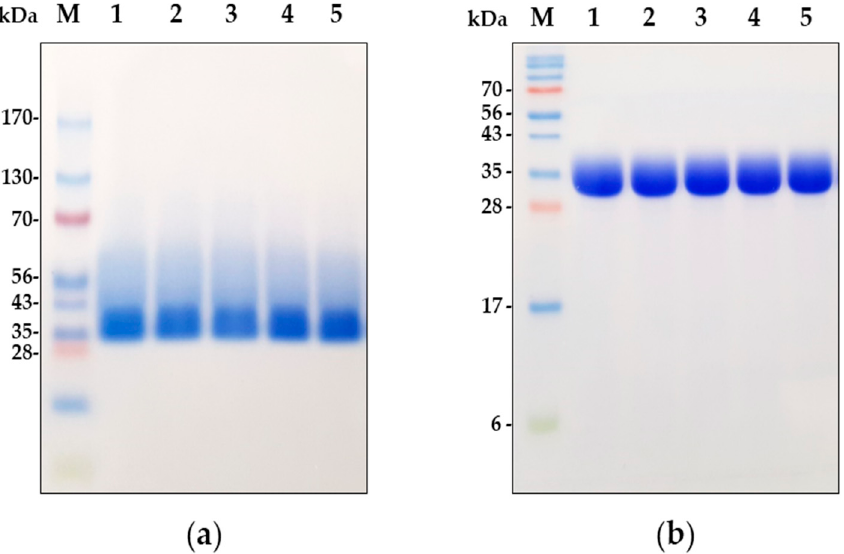
Figure 2. Representative native PAGE ( a ) and SDS-PAGE ( b ) analyses of dornase alfa aerosols generated by the four nebulizers: molecular weight standard ( lane M ), non-nebulized nominal ( lane 1 ), JN-PARIr ( lane 2 ), JN-PARIb ( lane 3 ), SMN-U150 ( lane 4 ), and VMN-SM1 ( lane 5 ).